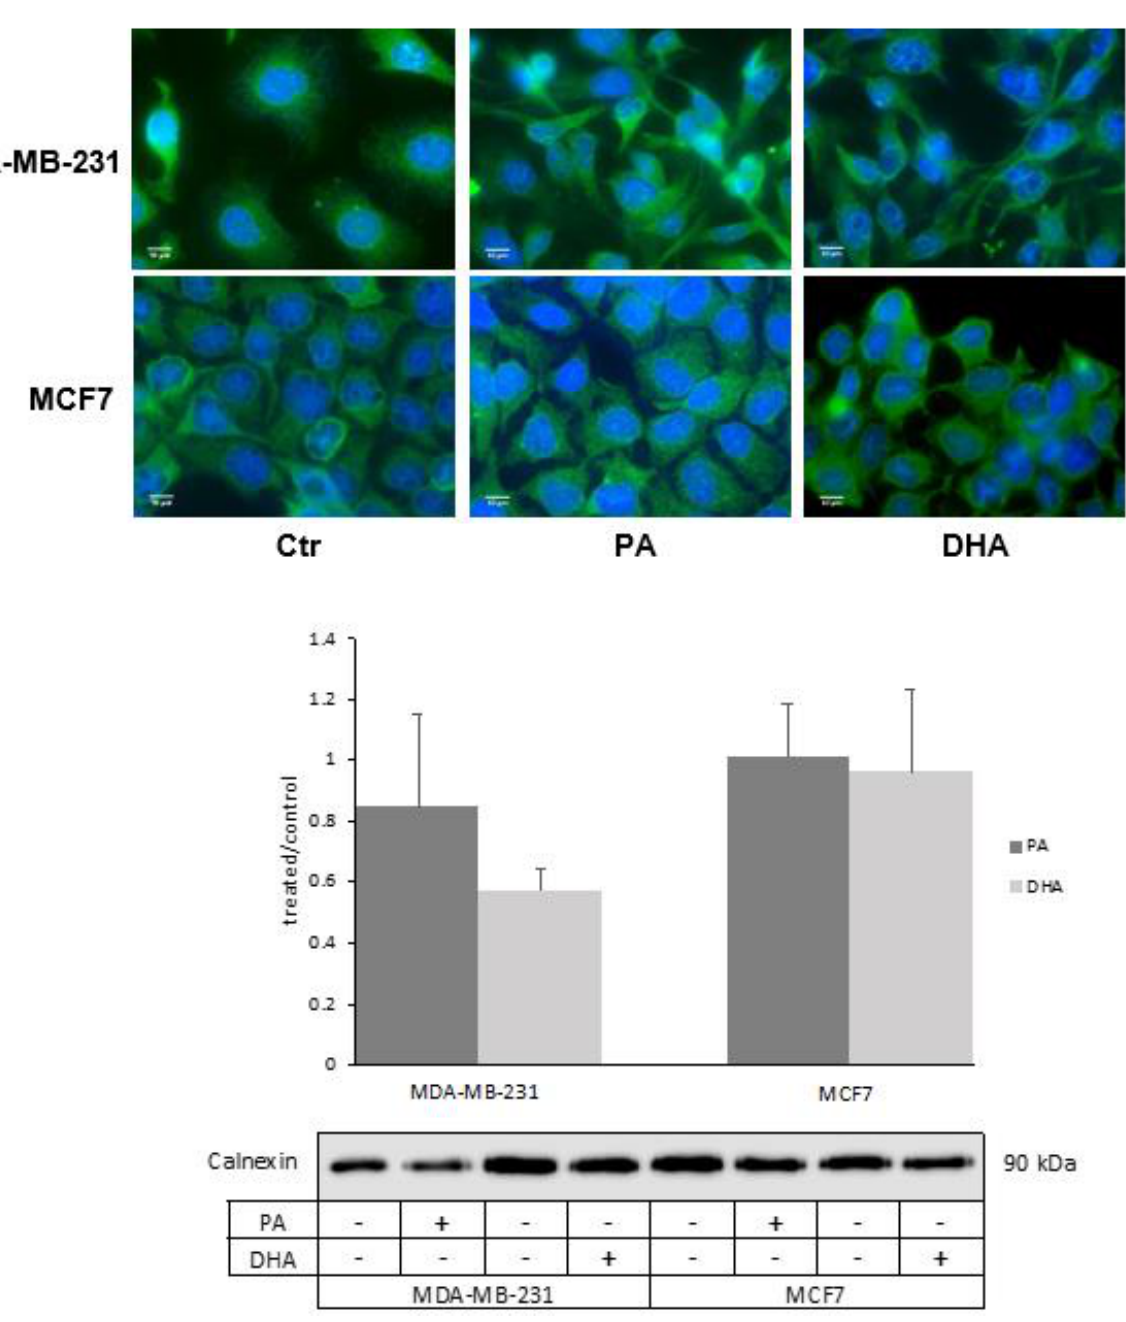
Figure 6. ( a ) Immunofluorescence analysis of the ER structure and ( b ) calnexin level in ER fractions of MDA-MB-231 and MCF7 cells treated with PA or DHA (50 µM) for 72 h: DAPI (nucleus in blue) and calnexin (ER in green).